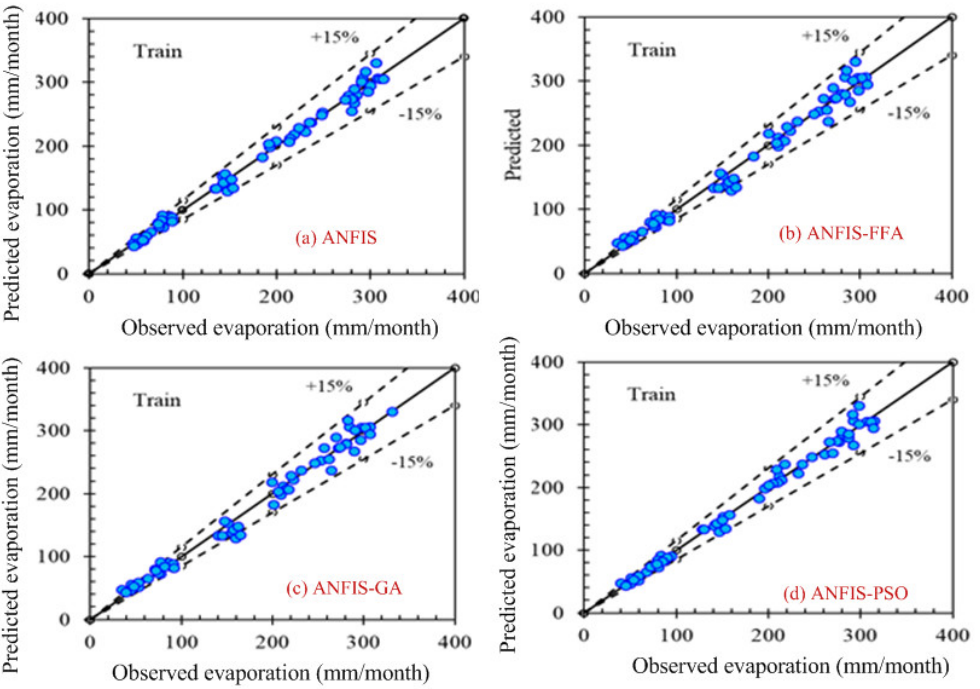
Figure 4. Comparison of the target (predicted) and obtained output sample index of training data set for ( a ) ANFIS, ( b ) ANFIS–FFA, ( c ) ANFIS–GA, and ( d ) ANFIS–PSO, respectively, using the first combination of the data set.